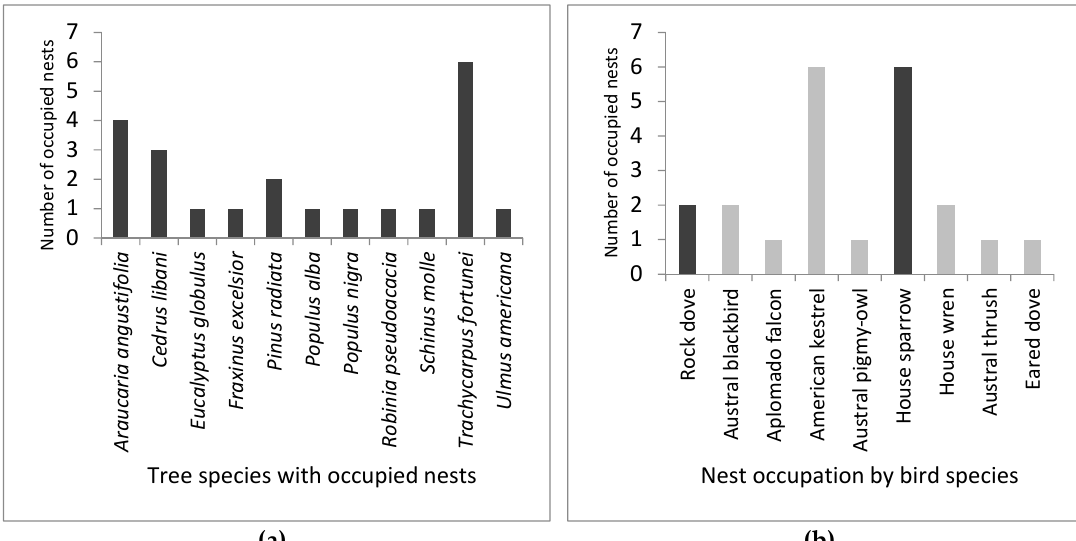
Figure 1. Monk parakeets’ nest occupation events ( n = 22) by sympatric bird species during Austral nesting seasons of 2017 and 2018 in Santiago, Chile. The ordinate axis shows frequency of events, while the abscissa list species: ( a ) Tree species with occupied nests; ( b ) nest occupation by bird species. Darker columns inform introduced species, while lighter columns inform native species.